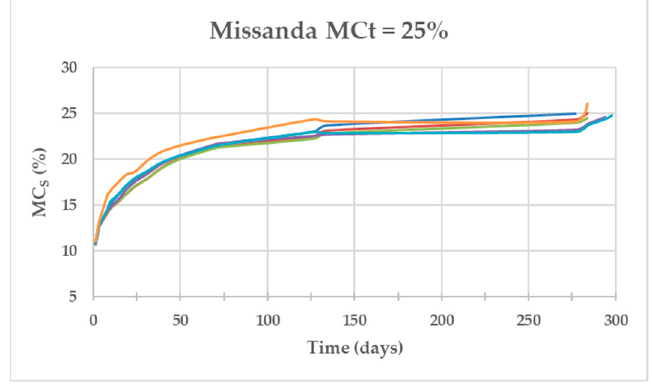
Figure 5. Evolution of the MC of the six Salzmann pine specimens as a function of time for MCt = 25%.